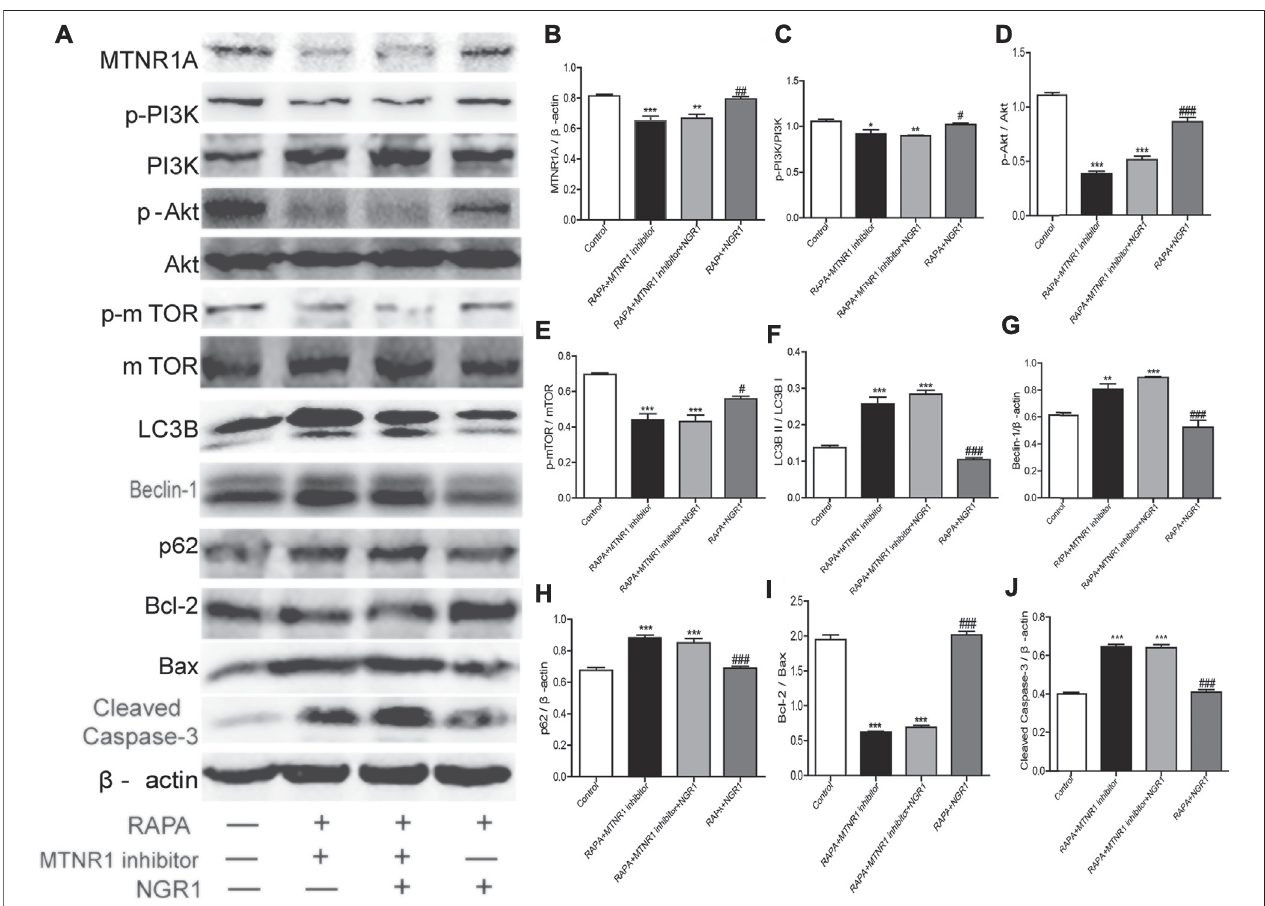
FIGURE6 | MTNR1Ainhibitor abolished the alleviative effects ofNGR1 on the expressions ofproteins involved in autophagy and apoptosis inHT-22 cellsinduced by rapamycin. After being pretreated with rapamycin (50 µg/ml) for 4 h, the cells were exposed to NGR1 (20 μ M) or NGR1 (20 μ M) and the MTNR1 inhibitor (10 µM) for 48 h. (A) Protein bands. (B) – (J) Gray intensity analysis of the protein bands. n (cid:1) ?/group. * p < 0.05, ** p < 0.01, *** p < 0.001 vs. control group. # p < 0.05, ## p < 0.01, ### p < 0.001 vs. RAPA + MTNR1 inhibitor + NGR1 group. (NGR1: notoginsenoside R1; MTNR1: melatonin receptors 1; 3-MA, 3-methyladenine; mTOR, mammalian target of rapamycin; p62, ubiquitin-binding protein p62 or sequestosome-1; p-Akt, phosphorylated PKB; p-PI3K, phosphorylated